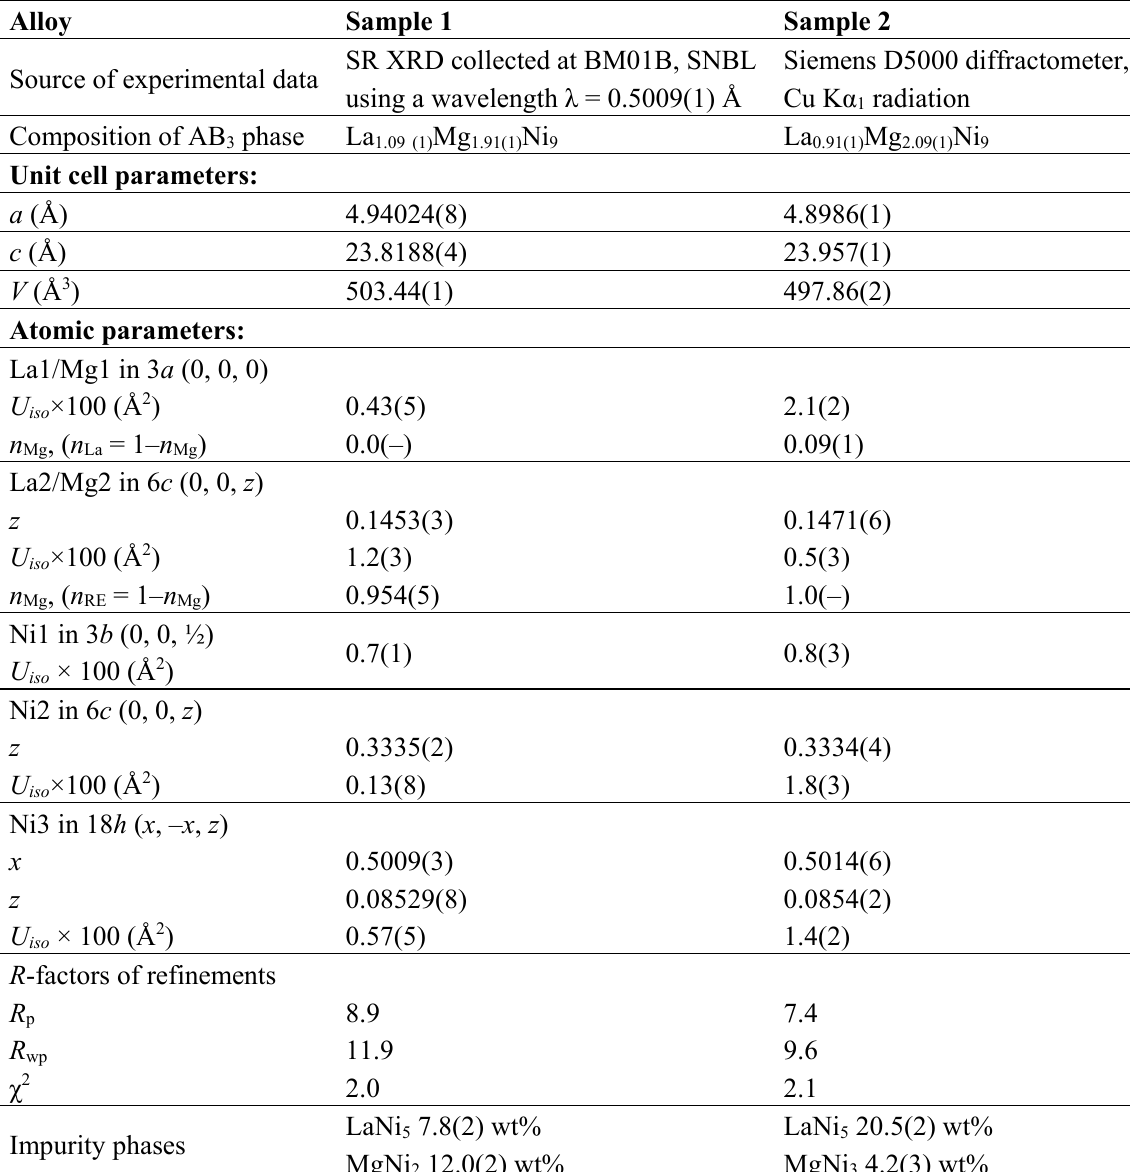
Table 1. Crystal structure data for the La 0.91 Mg 2.09 Ni 9 and La 1.09 Mg 1.91 Ni 9 alloys